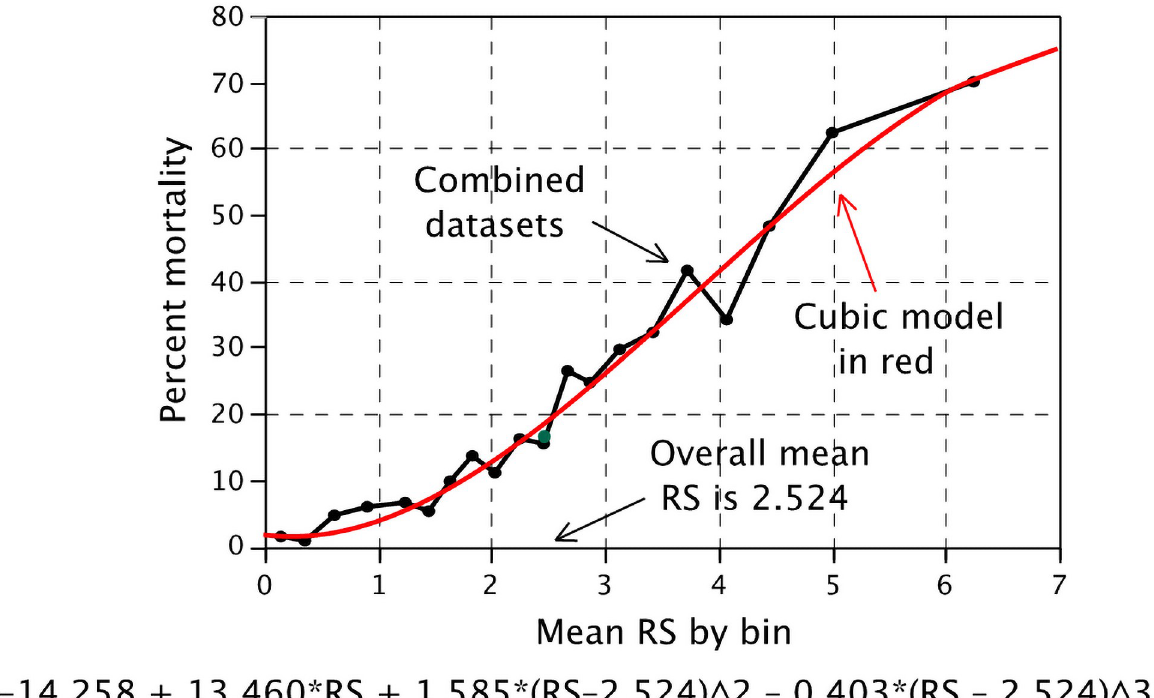
Fig 4. Patient-specific risk of mortality by day 40 using actual mortality in